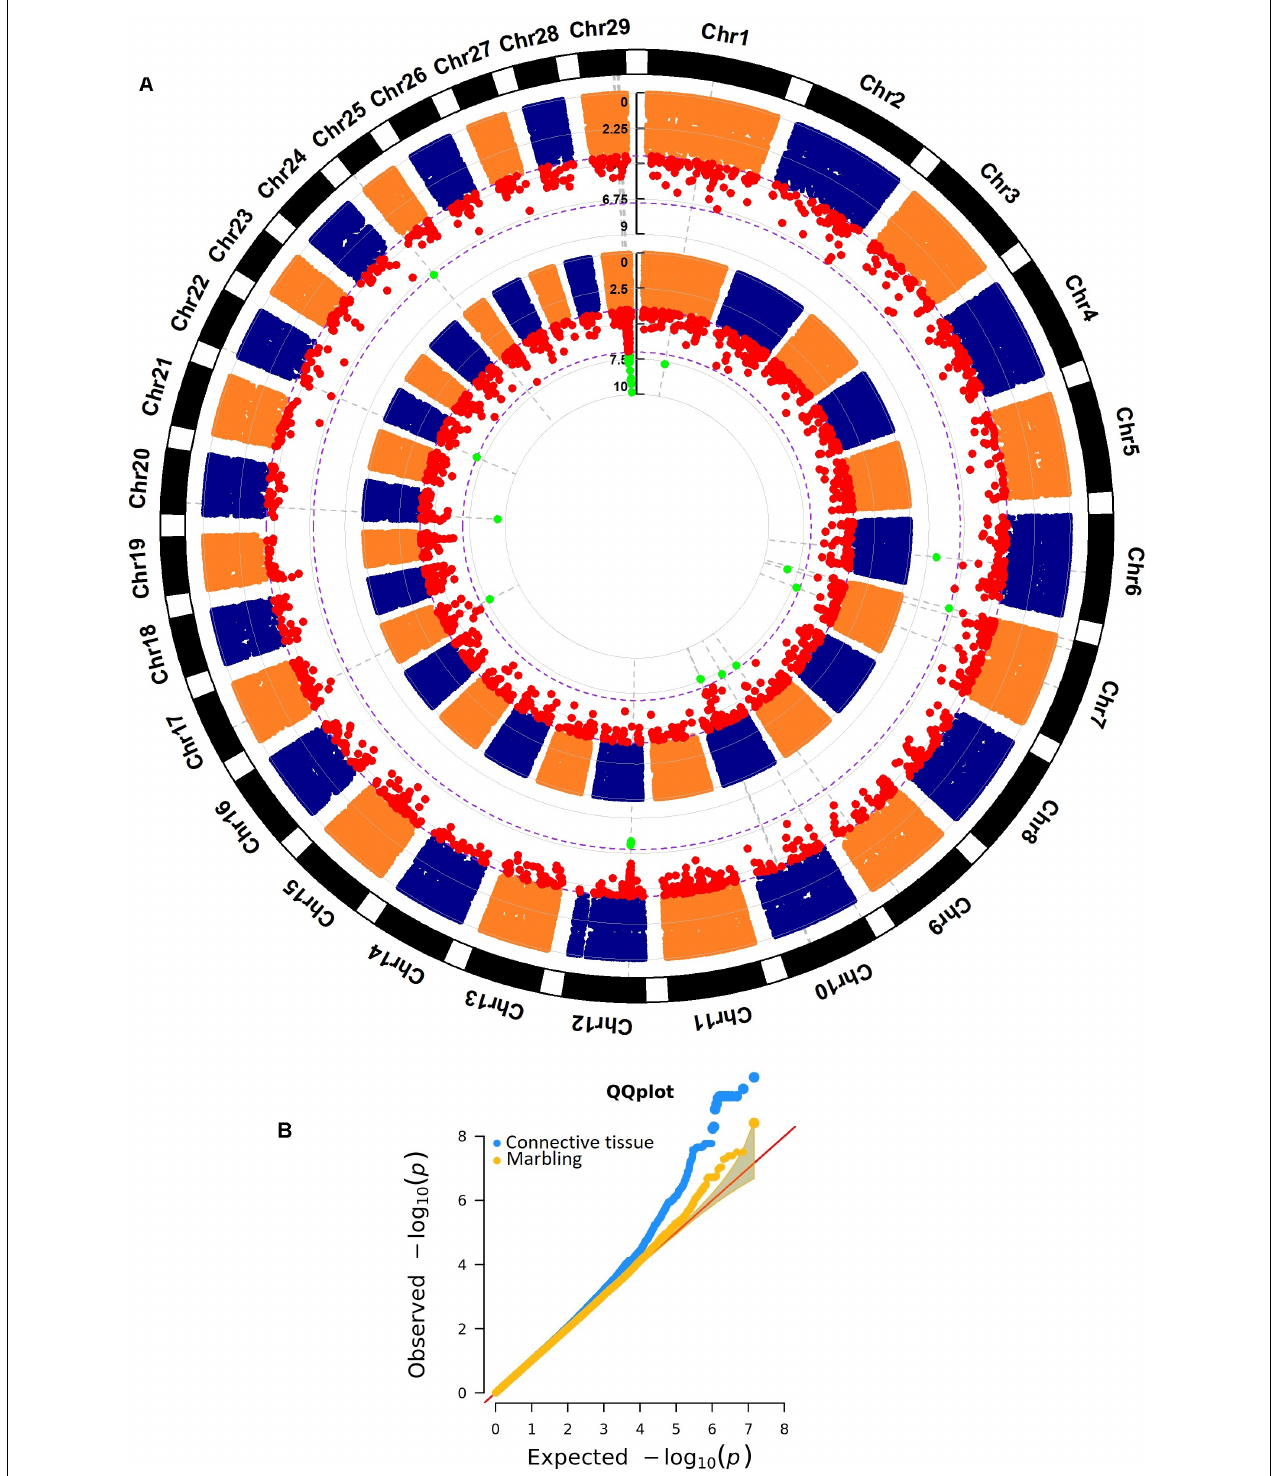
FIGURE 2 | (A) Whole genome association results for connective tissue (internal Manhattan plot) and marbling (external Manhattan plot) in longissimus dorsi muscle in an Angus population. The significance thresholds are 1 × 10 - 4 and 1 × 10 - 7 , respectively. (B) Q–Q plot for the whole genome association analyses for connective tissue and